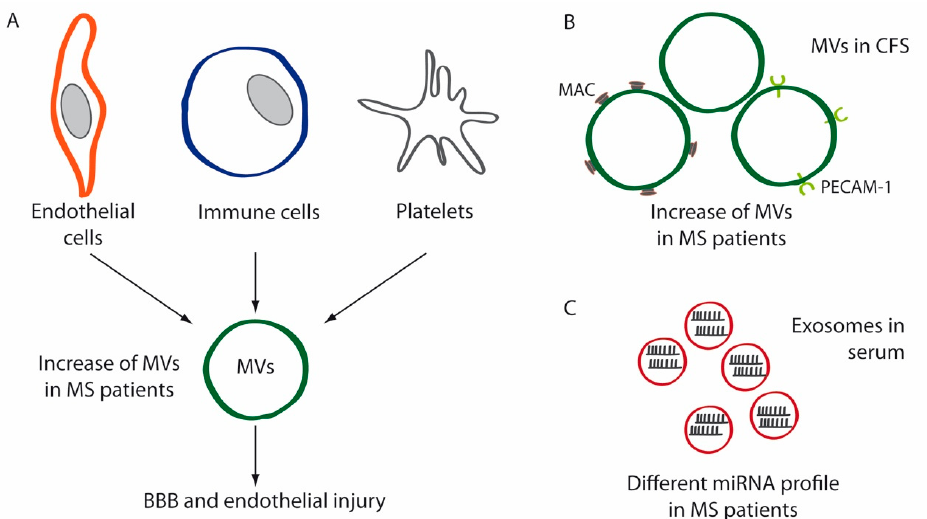
Figure 2. Schematic diagrams depicting the implication of extracellular vesicles (EVs) in MS. ( A ) MVs secreted by endothelial cells, immune cells and platelets are increased in the plasma of MS patients compared to healthy controls. These MVs contribute to blood–brain barrier (BBB) disruption and endothelial injury in these patients. ( B ) MVs isolated from the cerebrospinal fluid (CSF) of MS patients are increased compared to controls. These EVs are enriched in membrane attack complex (MAC) components and platelet-endothelial cell adhesion molecule-1 (PECAM-1). ( C ) Circulating exosomes have a different miRNA profile in MS patients.